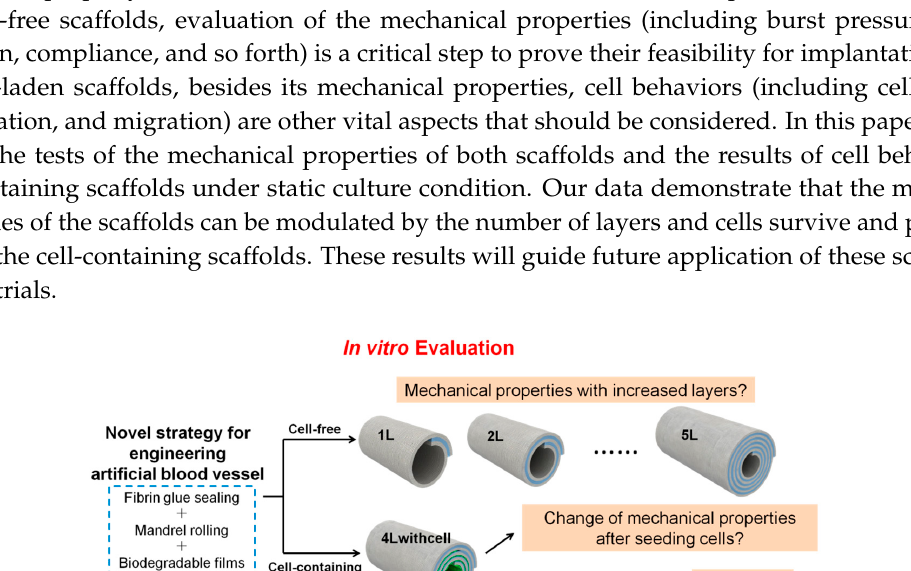
proliferation, and cell migration) within scaffolds will be evaluated.